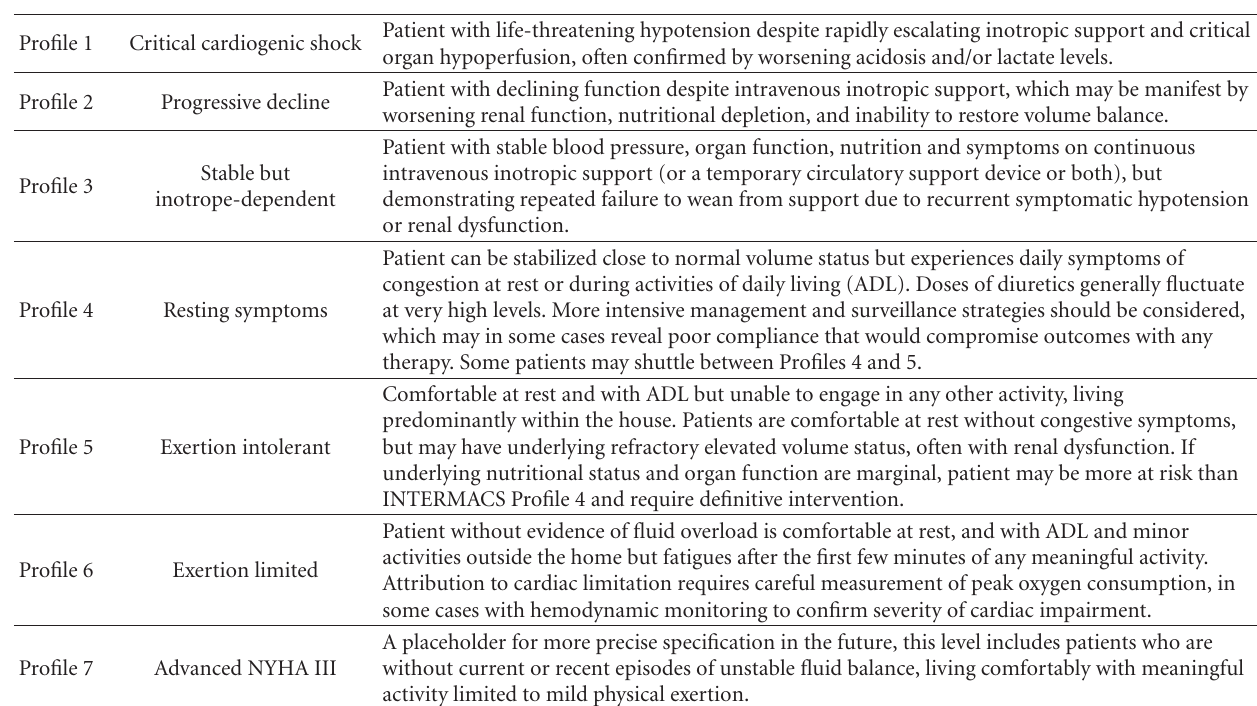
Table 2: Interagency registry for mechanically assisted circulatory support (intermacs) levels ( with permission from [39]). Profile